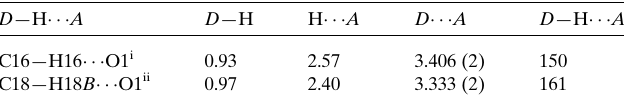
Table 2 Hydrogen-bond geometry (A˚ , (cid:3) ) for (II).